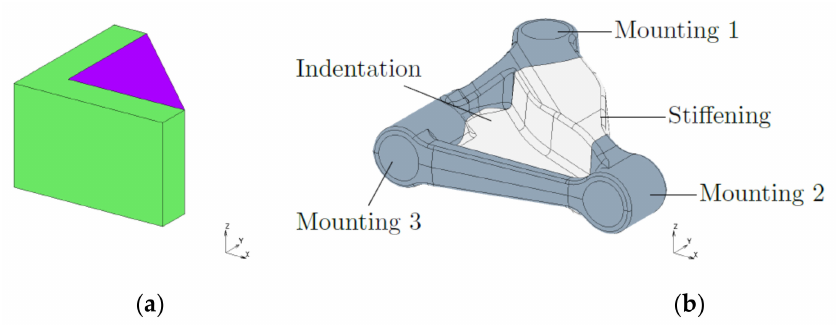
Figure 7. Transverse link; raw ( a ) and final geometry ( b ).